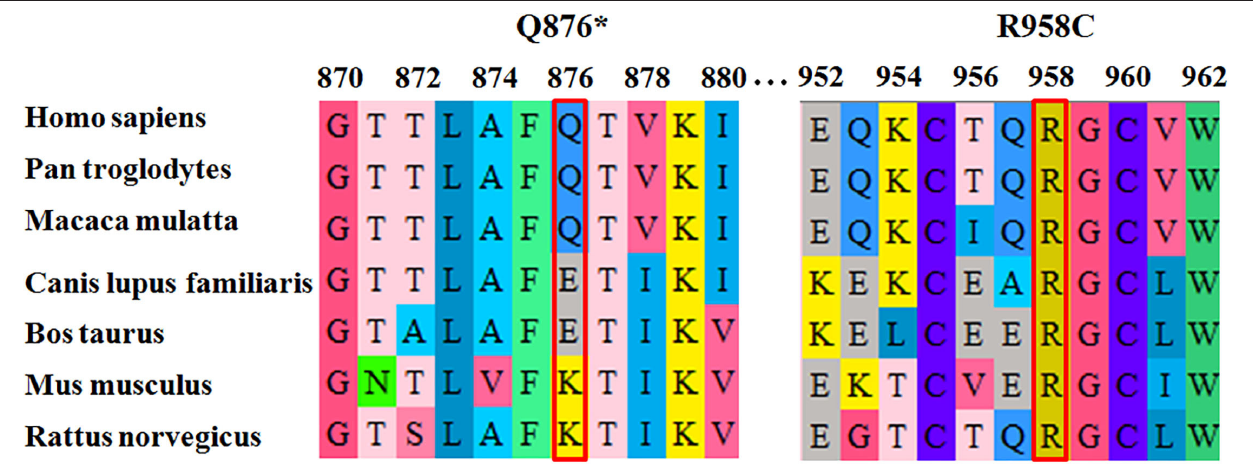
( Figure 3 ), which indicates the functional importance of